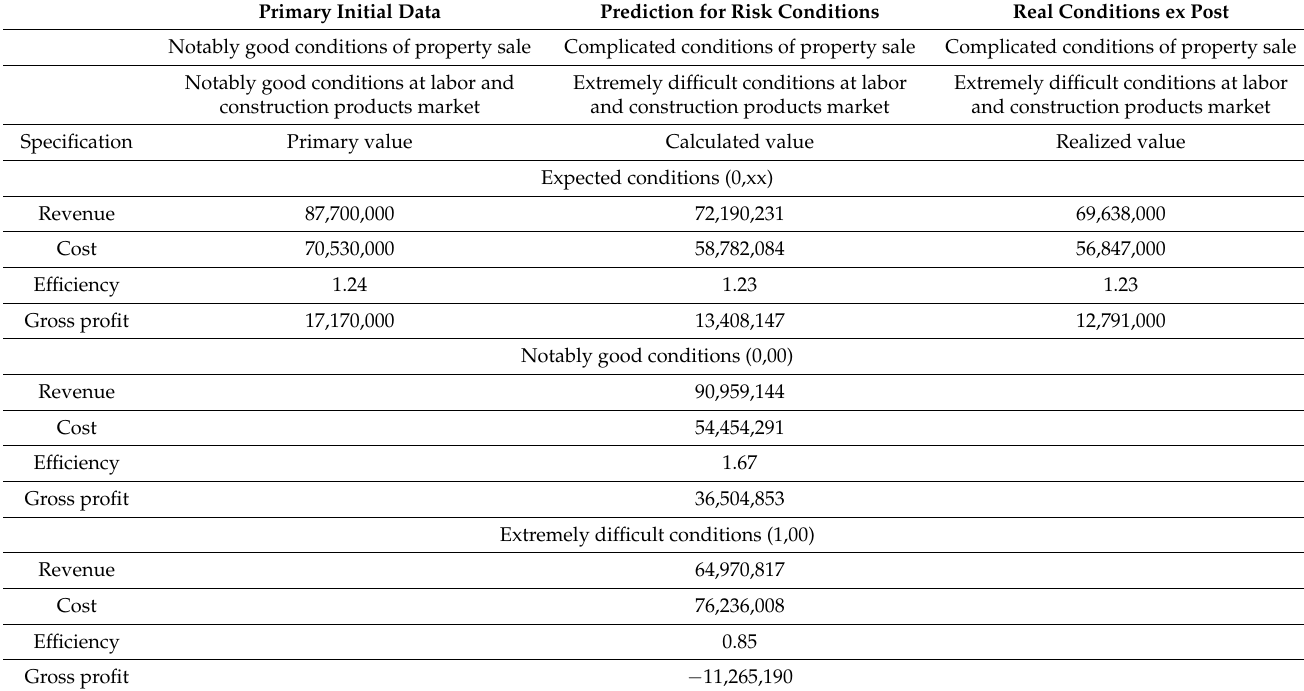
Table 6. Final results for conditions initially planned, actually expected, and really occurred for investment 2.